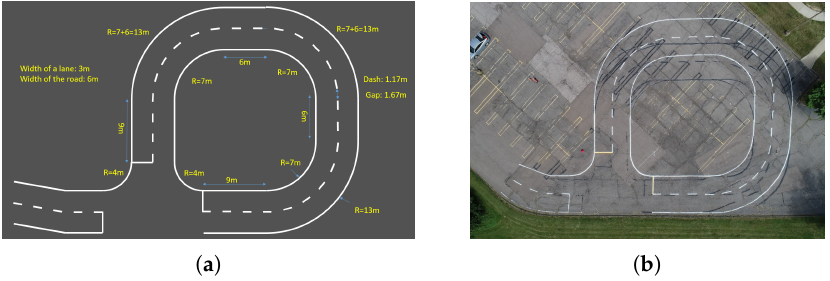
Figure 2. Environment: ( a ) One-to-one map of the test course in Parking Lot H used in simulation. The width of the lane, width of the road, radius for the turns, etc. are labelled in the above figure; ( b ) Bird’s-eye view of the test course in Parking Lot H at Lawrence Technological